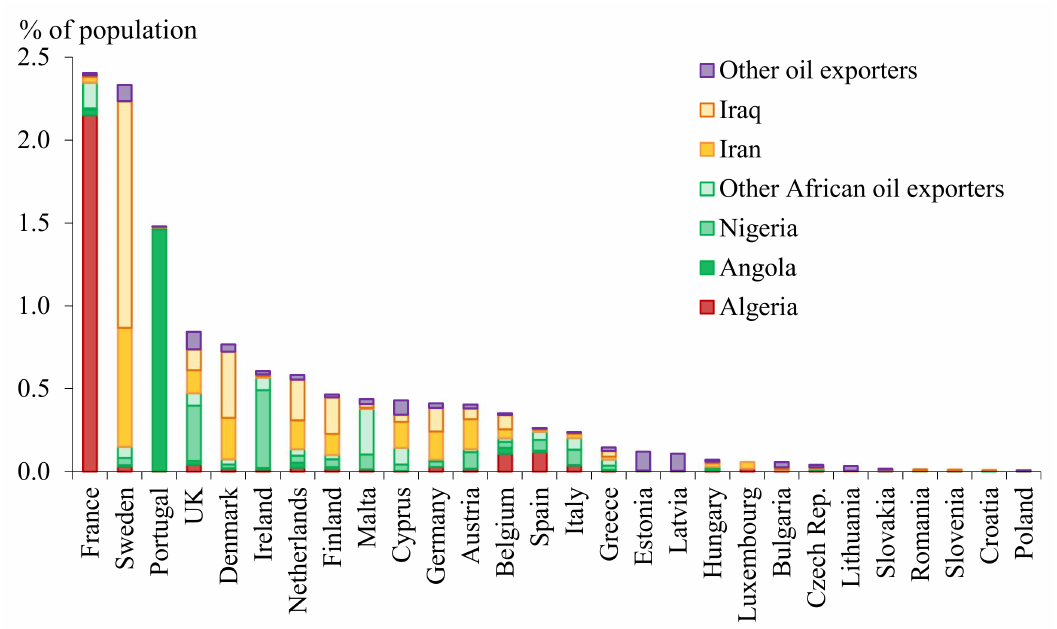
Figure A2. Origin of foreign residents in the EU28 (mid-2015). Data source: